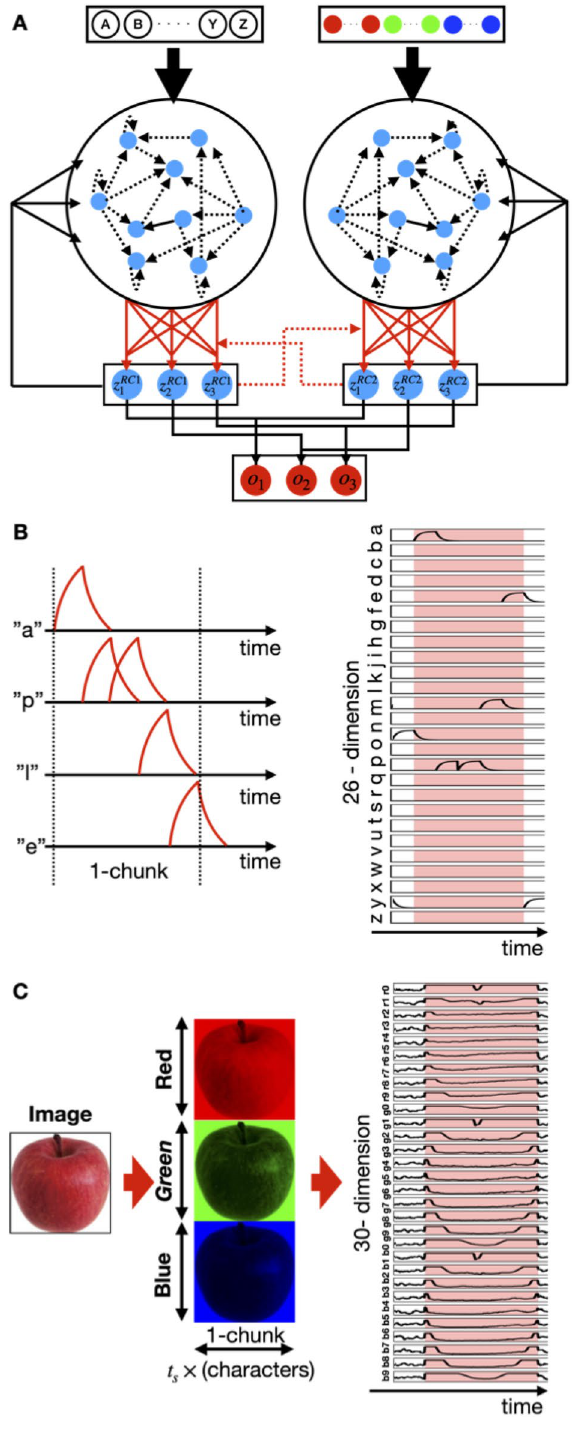
Figure 1. Collaborative multimodal reservoir computing model and signals used. ( A ) In the collaborative multimodal reservoir computing (RC) model, two non-identical reservoirs are activated by different input neurons’ activity. The readout weights of each RC system undergo supervised learning with a teaching signal generated by the output of the partner network. Each input neuron of RC receives different modality inputs. In this simulation, we used a text-tone signal and an image signal. ( B ) Example responses are provided for input neurons to the text-tone modality signal. ( C ) Example responses are provided for input neurons to the image modality signal. Our demonstration uses three chunks, with each chunk displaying a fruit, namely an apple, grape, and